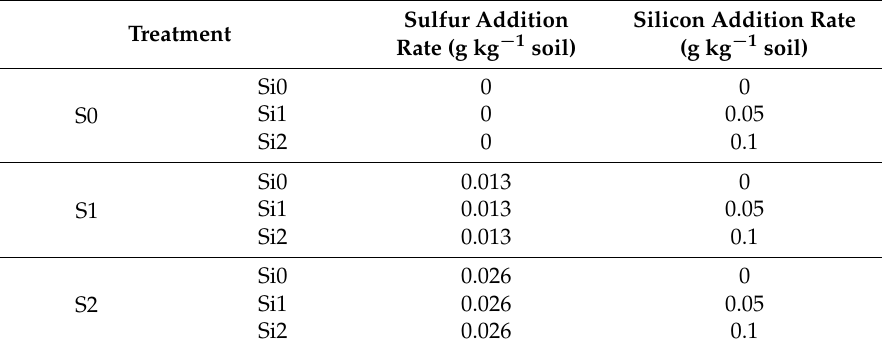
Table 1. Outline description for the fertilization